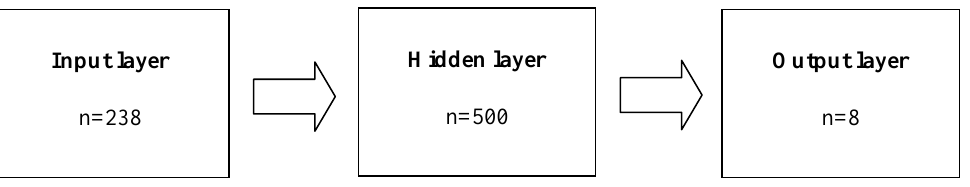
Figure 15. Optimal full-size ANN.